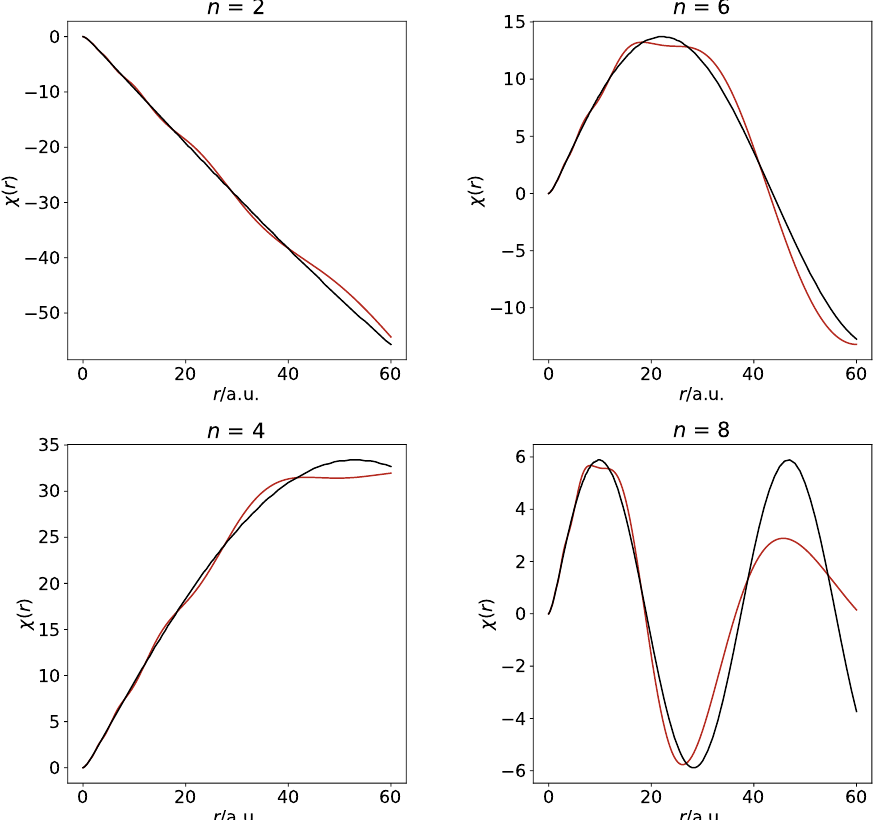
Figure 8. Eigenfunctions obtained from solving the generalized eigenvalue problem (6) in the static approximation (red) and those obtained using the atomic codes [33] (black) for n = 2,4,6 and